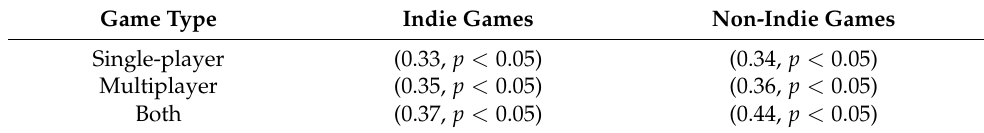
Table 4. Correlation between game prices and game